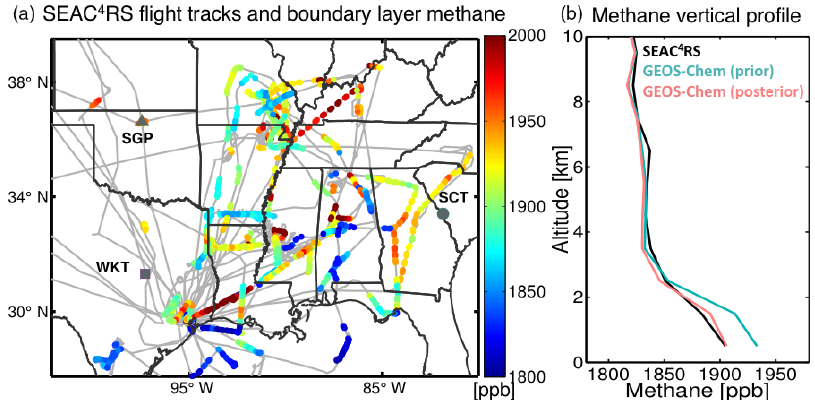
Figure 2. Boundary layer methane concentrations over the Southeast US measured during the SEAC 4 RS aircraft campaign (6 August– 21 September 2013). Panel (a) shows the flight tracks in grey and the methane measurements at 0–2km altitude. The three NOAA / ESRL sites at SGP (Southern Great Plains, Oklahoma; 36.6 ◦ N, 97.5 ◦ W), WKT (Moody, Texas; 31.3 ◦ N, 97.3 ◦ W), and SCT (Beech Island, South Carolina; 33.4 ◦ , 81.8 ◦ W) are indicated. SGP is co-located with the TCCON site at Lamont, Oklahoma. Panel (b) shows the mean methane vertical profiles over the Southeast US domain measured from the aircraft and simulated by GEOS-Chem using the prior and posterior emissions.